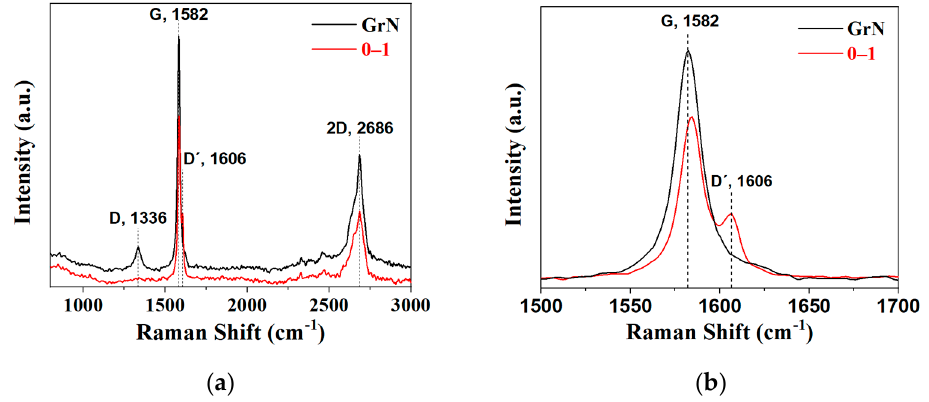
Figure 5. Raman spectra of raw graphite and the intercalated material ( a ) and magnification on the G band zone ( b ).